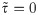
Schematic view of the phase portrait at τ~=0.The value q = 0 corresponds to the unfolded state of the VWF molecule; and q = qm, to the folded state. q = qs is a saddle point, and the curve ASB denotes the separatrix.